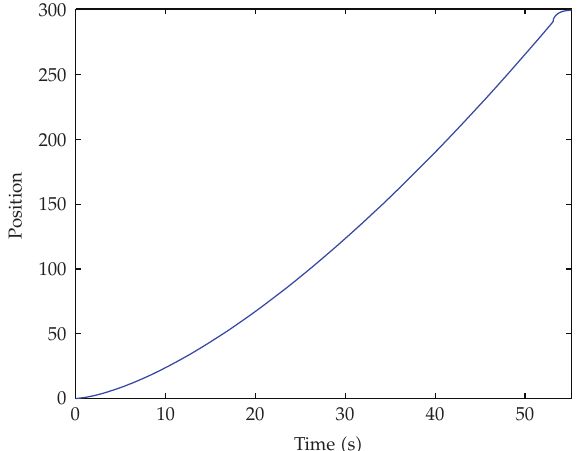
Figure 6: States x (cid:5) t (cid:6) as functions of time t for the Bang-Bang control problem for α (cid:7) 0 . 5.